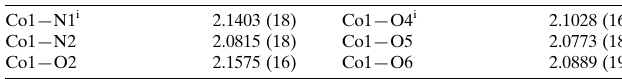
Selected bond lengths (A˚ ).